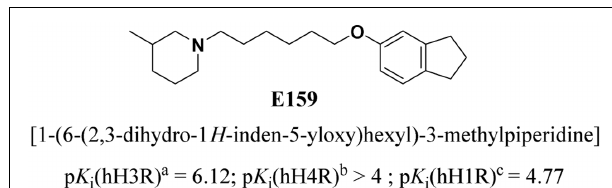
FIGURE 1 | Chemical structure and in vitro affinities of the non-imidazole H3R antagonist/inverse agonist E159. a [ 125 I]Iodoproxyfan binding assay at human H3Rstably expressed in CHO-K1 cells, n = 3 (Ligneau et al., 1994; Ligneau et al., 2000; Lazewska et al., 2006). b [ 3 H]Histamine binding assay performed with cell membrane preparation of Sf9 cells transiently expressing the human histamine H4Rand co-expressed with G α i2 and G β 1 γ 2 subunits, n = 3 (Meier et al., 2001; Amon et al., 2007; Isensee et al., 2009; Tomasch et al., 2013). c [ 3 H]Pyrilamine binding assay performed with cell membrane preparation of CHO-hH1Rcells stably expressing the human H1R, n = 3 (Schibli and Schubiger, 2002; van Staveren and Metzler-Nolte, 2004; Schlotter et al.,